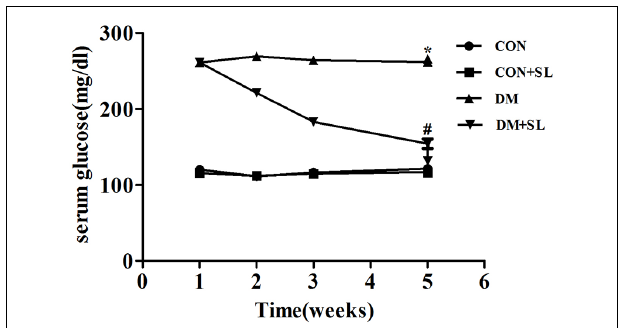
FIGURE 1 | Effect of strawberry leaf extract on FPG. Data are shown as mean ± SD. * p < 0.05 vs. CON group; # p < 0.01 vs. diabetes mellitus (DM) group, n =